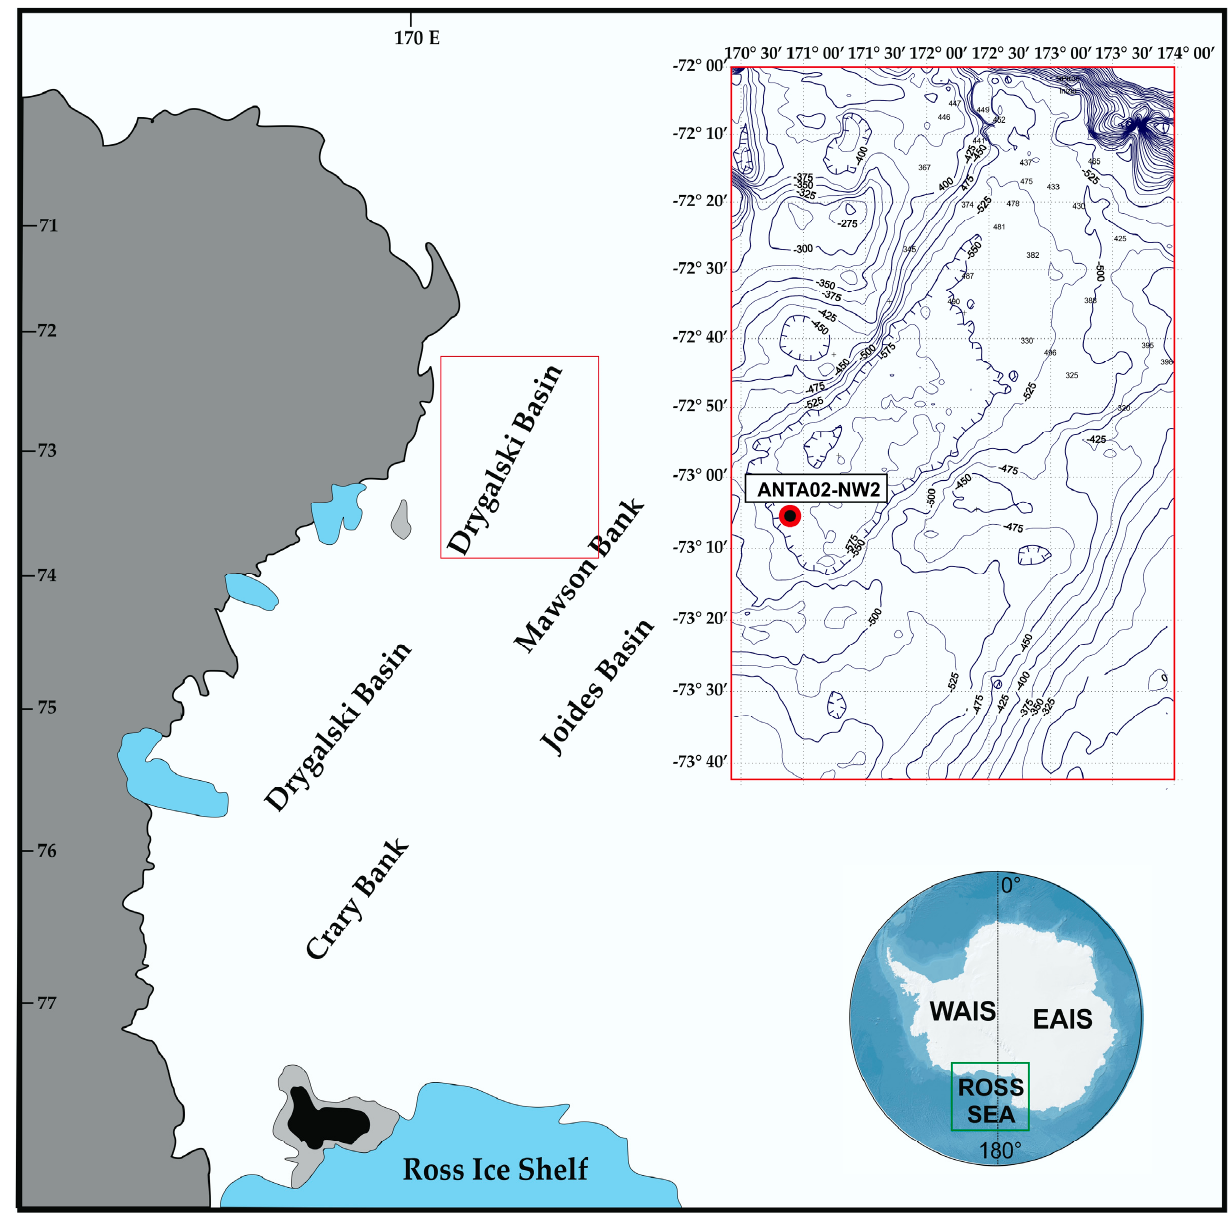
Figure 1. Study area with the location of core ANTA02-NW2 collected in 2002 during the XVII PNRA cruise. The detailed map of the study area is shown in the red inset. Map created using [54] with modified bathymetry. Isobaths every 25 m.